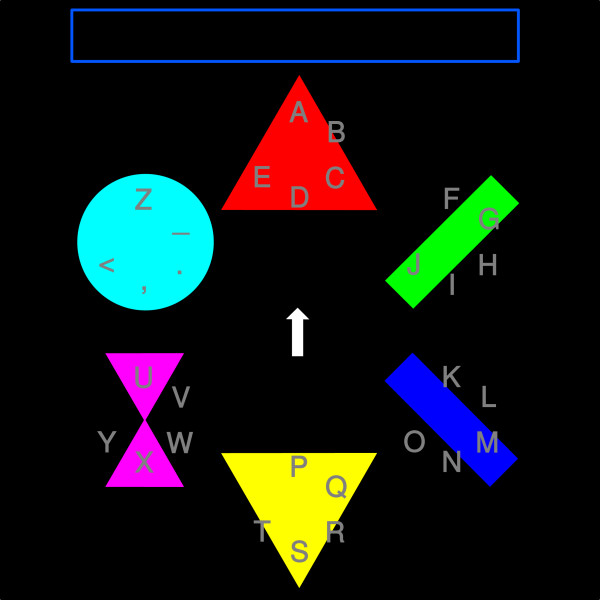
Calibration Experiment. The central arrow rotates clockwise and the participant has to press a key when the arrow passes the target symbol. The visual feedback is identical with the feedback of the Center Speller.